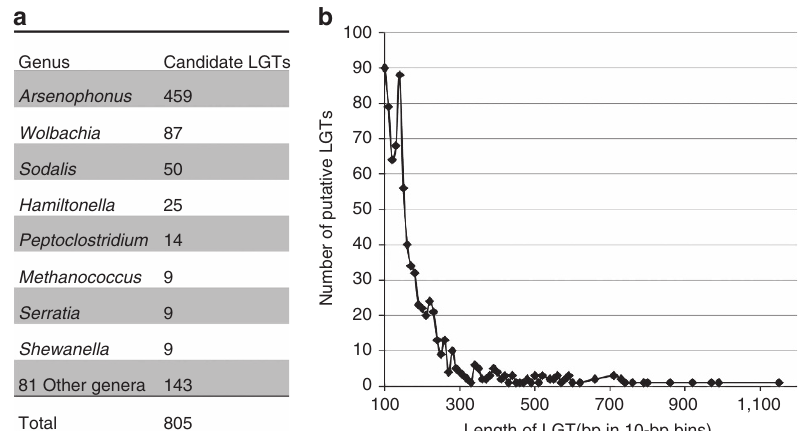
Figure 3 | Summary of putative lateral gene transfers (LGTs) 4 100bp in the C. lectularius assembly. ( a ) Number of candidate LGTs identified. ( b ) Length of candidate LGTs in bins spanning